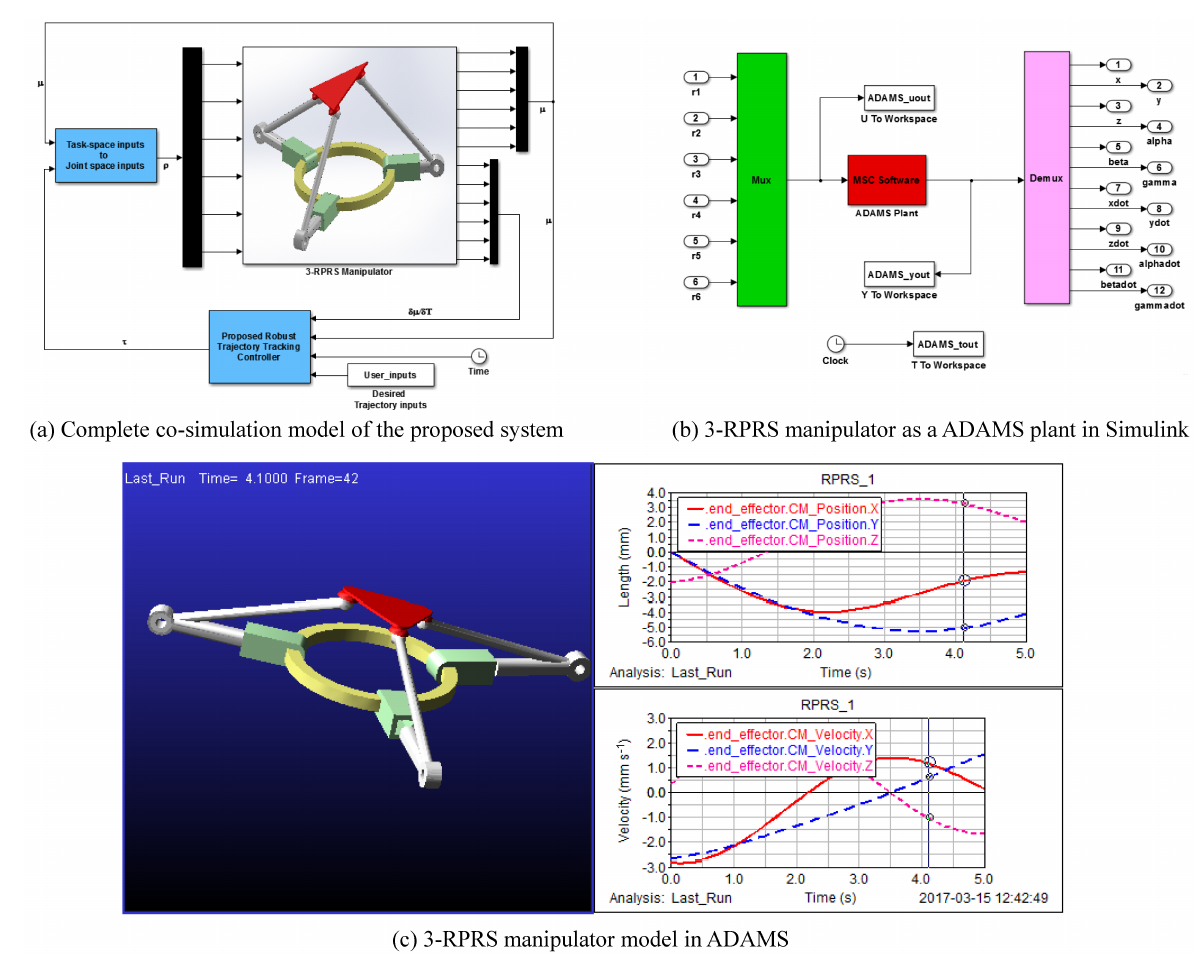
Figure 4. Block diagram representation of the proposed robust task-space control